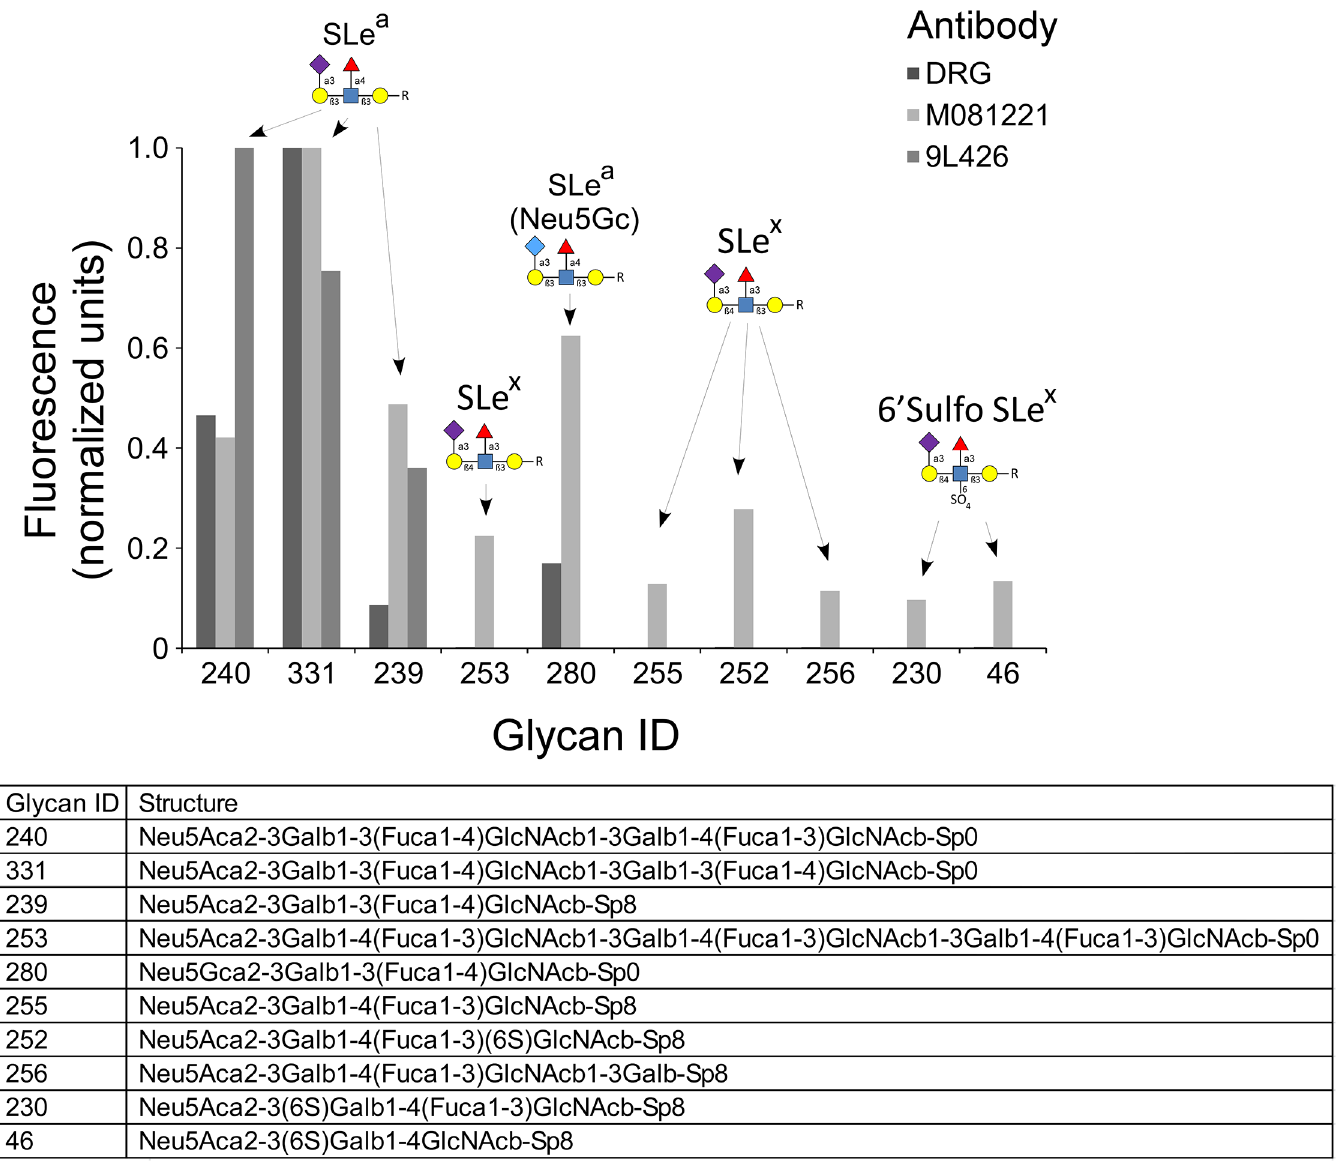
Fig 3. Glycan array analysis of three CA 19 – 9 antibodies. Each antibody was incubated at 2 μ g/mL on a glycan array containing 610 distinct glycans (glycan array version 5.1 from the Consortium for Functional Glycomics). The graph includes the glycans showing the highest levels of binding by any of the antibodies. For each antibody, we normalized the raw fluorescence values to set the highest value to 1. The list specifies the glycans included in the plot, and the labels above the columns indicate the primary motif in each glycan. DRG is the Assay 1 antibody, 9L426 is the Assay 2 antibody, and M081221 is another anti-sialyl Lewis A antibody included for